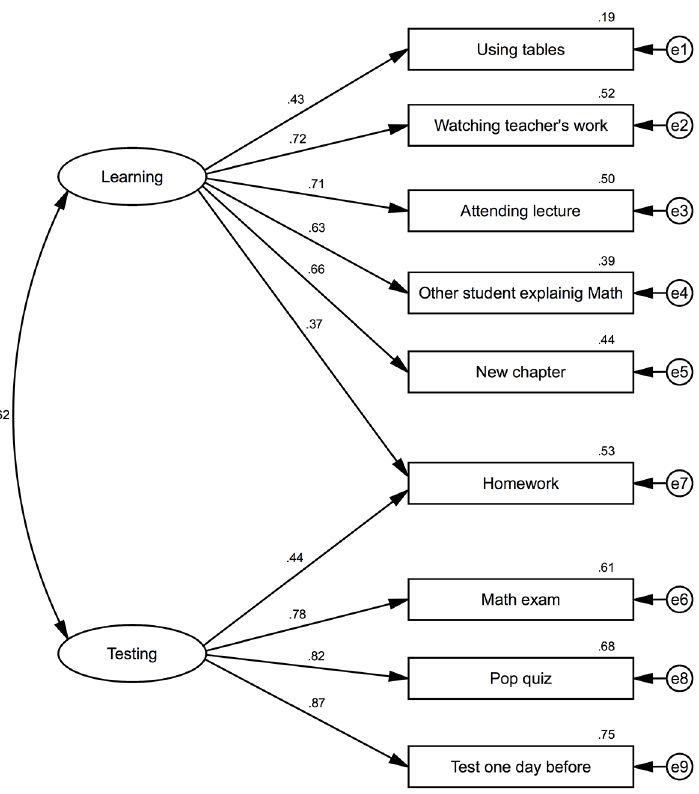
Figure 2. Confirmatory factor analysis on AMAS online data. Indices of the model fit are presented in the main text. Standardized coefficients are presented along with the respective paths. Internal structure of the AMAS online data is highly similar to paper-and-pencil data. Variables labelled with e1, e2, etc. denote respective error terms.